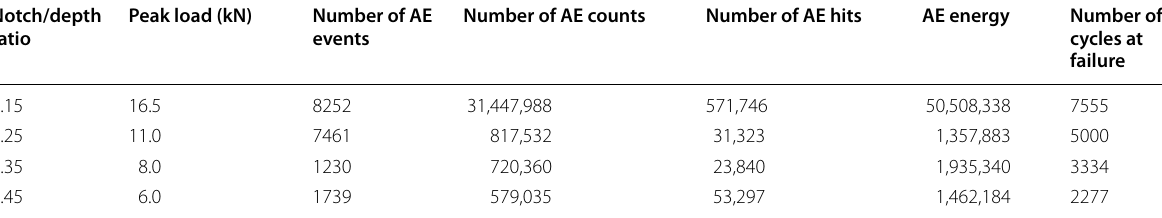
Table 4 AE data parameter for different types of notched